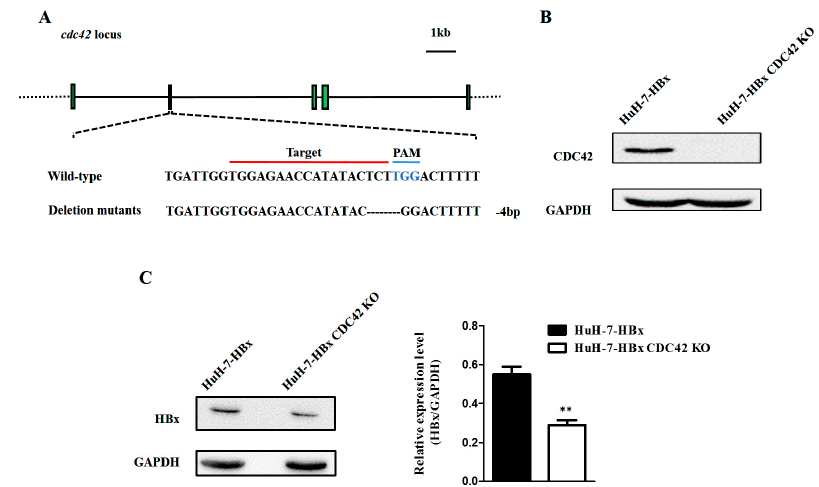
Figure 2. Knockout of CDC42 protein by the CRIPSR/Cas9 system. ( A ) Edited cdc42 gene in HuH-7-HBx genome through the CRISPR/Cas9 system. In HuH-7-HBx cells, there was a mutation of 4 base deletion near the PAM (Protospacer adjacent motif) in exon2 of cdc42 gene, which resulted in a frameshift mutation; ( B , C ) Western blot analysis for the expression of CDC42 ( B ) and HBx ( C ) in the HuH-7-HBx and HuH-7-HBx CDC42 KO cells. ** p < 0.01. Data represent the mean ± SEM of two independent experiments.